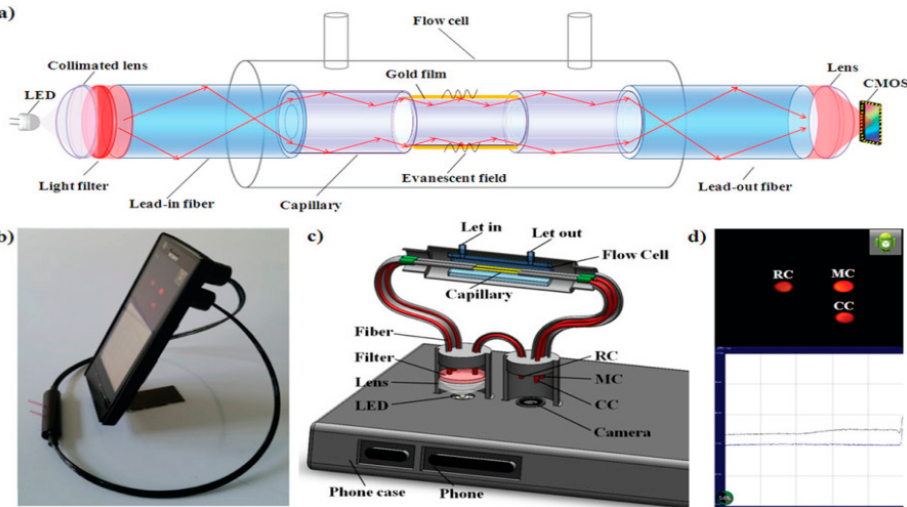
Figure 5. Schematic representation of a SPRi device coupled with a smart phone ( a ) SPRi cell with complementary metal-oxide-semiconductor (CMOS) camera and light emitting diode (LED) as a light source ( b ) photograph of the SPRi sensor installed on a smart phone ( c ) illustration of the opto-mechanical instrumentation ( d ) camera of the smart phone capturing images from the measurement, control, and reference channels (MC, CC and RC). This work is licensed under a